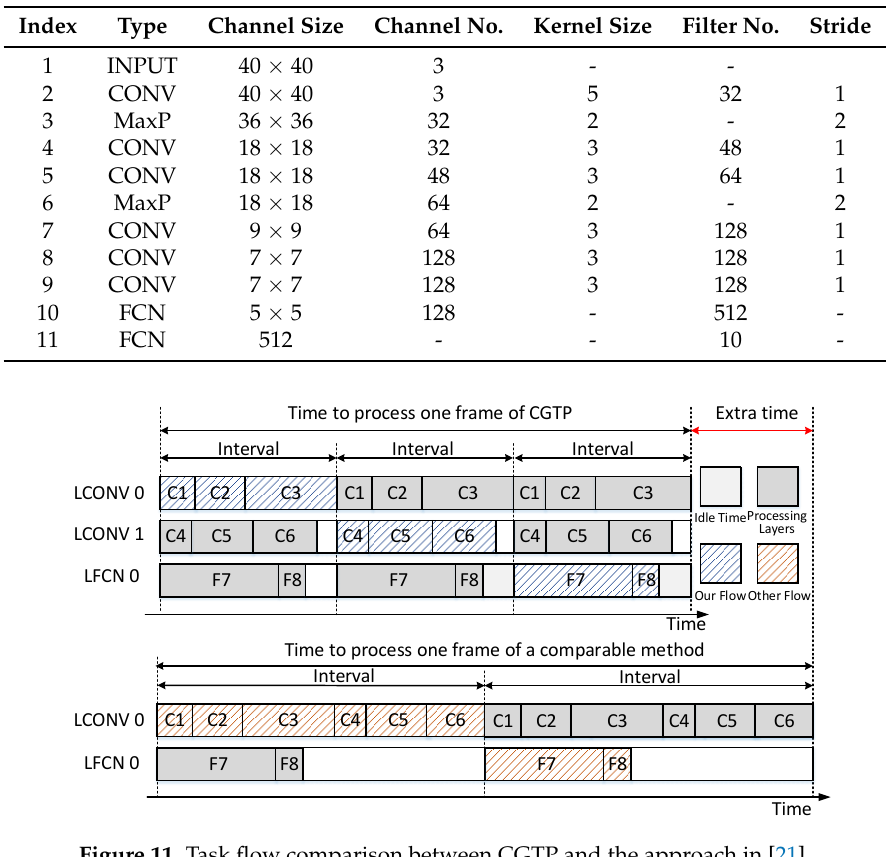
Figure 11. Task flow comparison between CGTP and the approach in [21].